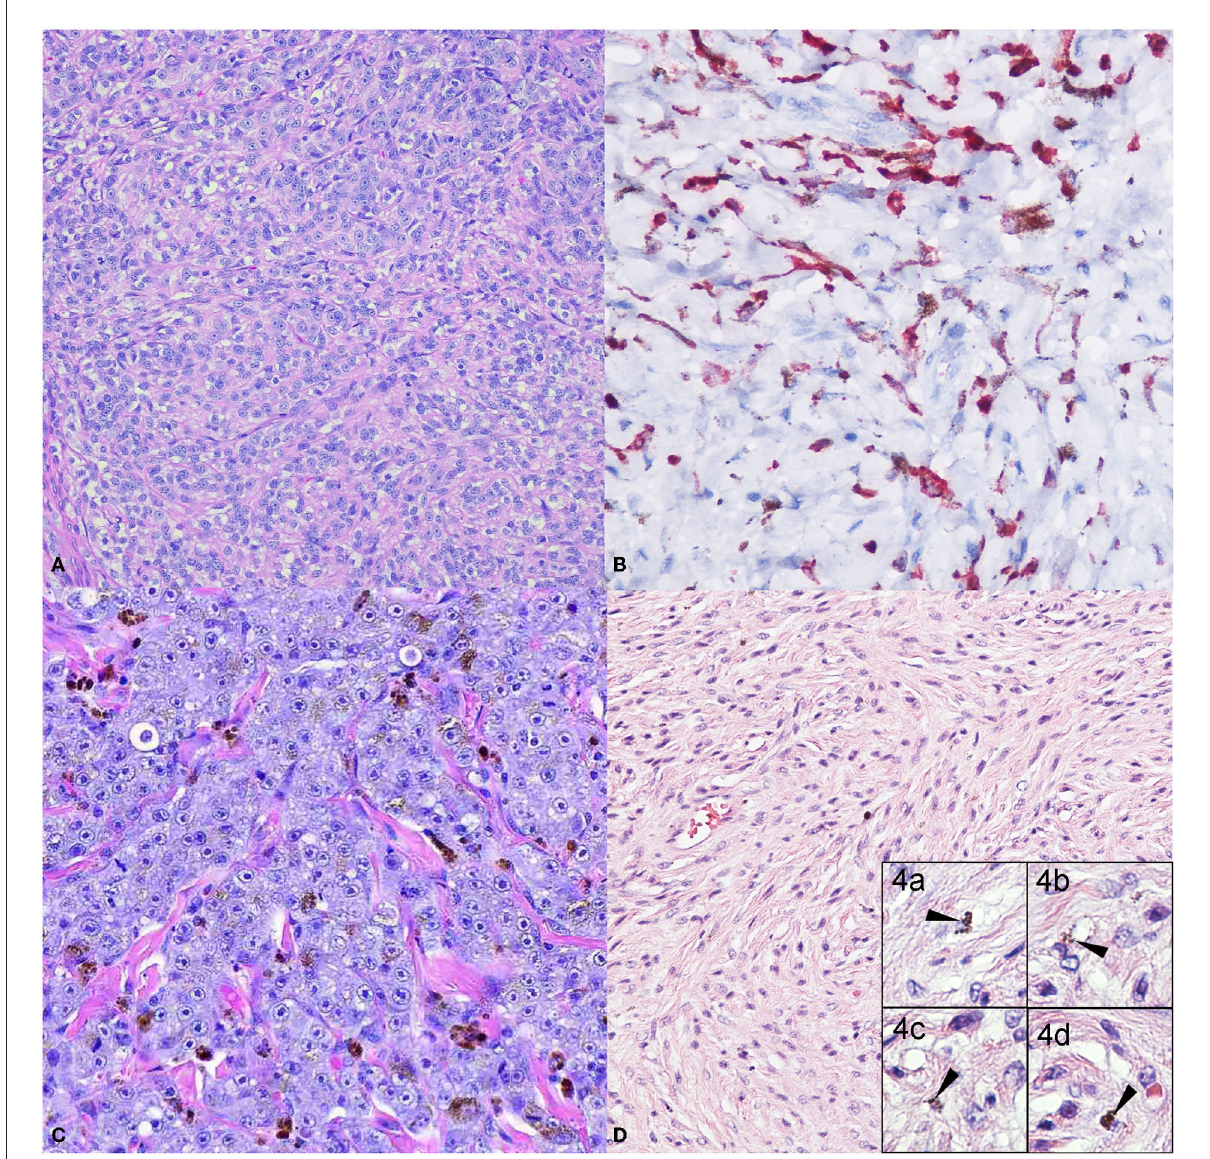
FIGURE1 Common canine melanoma morphologies. The panel shows the more classical melanoma morphologies. (A) Dog oral melanoma, 20X. Amelanotic, cords of polygonal cells with no apparent intracytoplasmic melanin granules. Neoplastic cells have a large nucleus with